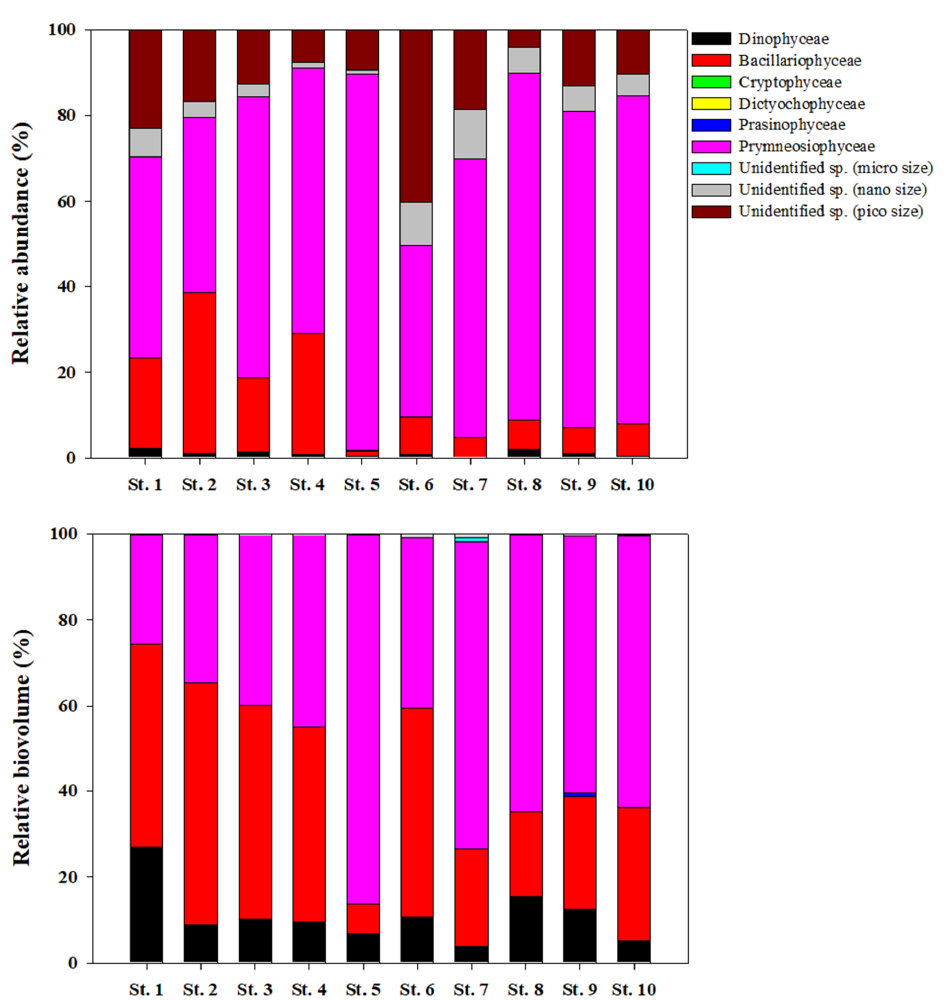
Figure 4. Relative abundance and biovolume of the phytoplankton taxa.